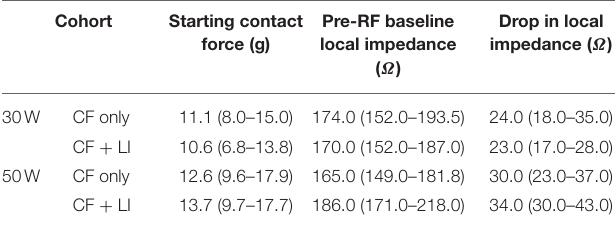
TABLE 1 | Summary statistics of CF and LI for all RF applications (median and quartiles). Cohort